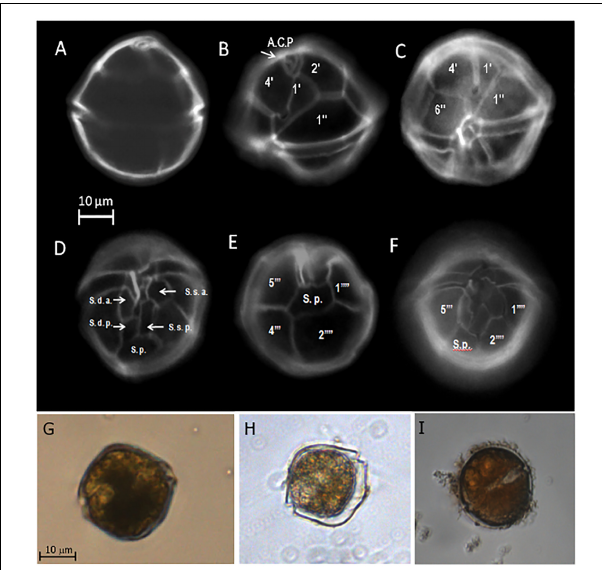
FIGURE 3 | Morphological characteristics of Alexandrium ostenfeldii collected in water samples from Todos Santos Bay region. The cells were stained with calcofluor to evaluate the thecal plate arrangement with epifluorescence microscopy. (A) Shape of the cells; (B) apical pore complex (APC) complex occupied by a prominent comma-shaped pore; (C) first precingular (1’) plate with a ventral pore; (D) ventral view showing the sulcal plates; (E) antapical view showing the sulcal posterior plate; (F) ventral view; (G,H) vegetative cells observed by inverted optical microscopy; (I) presence of cysts in the water samples.